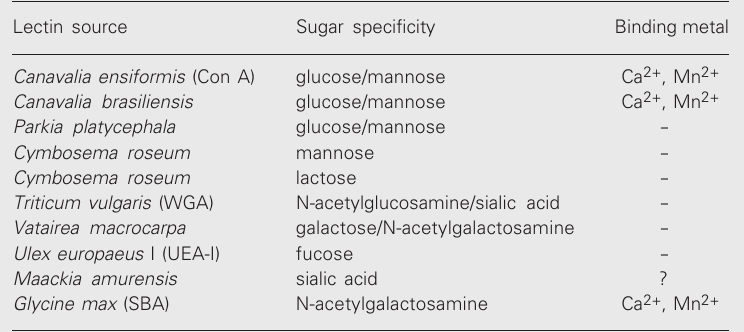
Table 1. General characteristics of the plant lectins